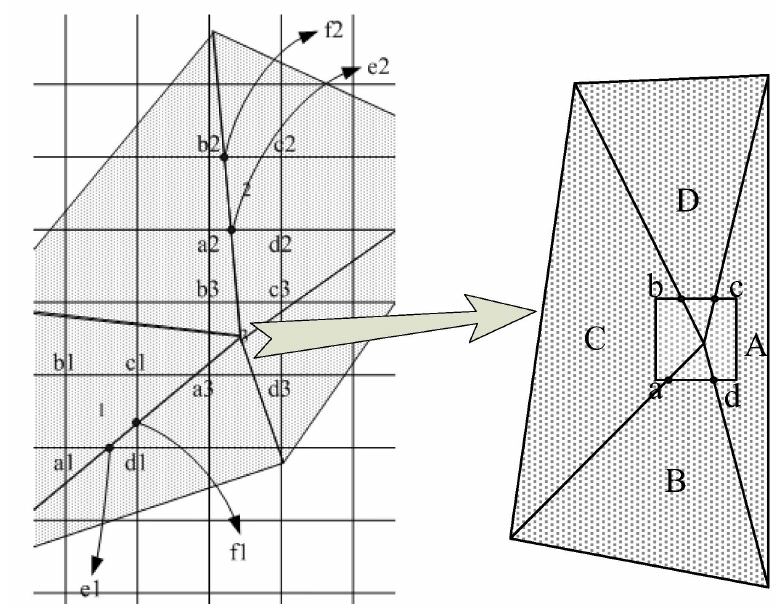
Figure 6. Local and special cases of the intersection between the plane element and acoustic